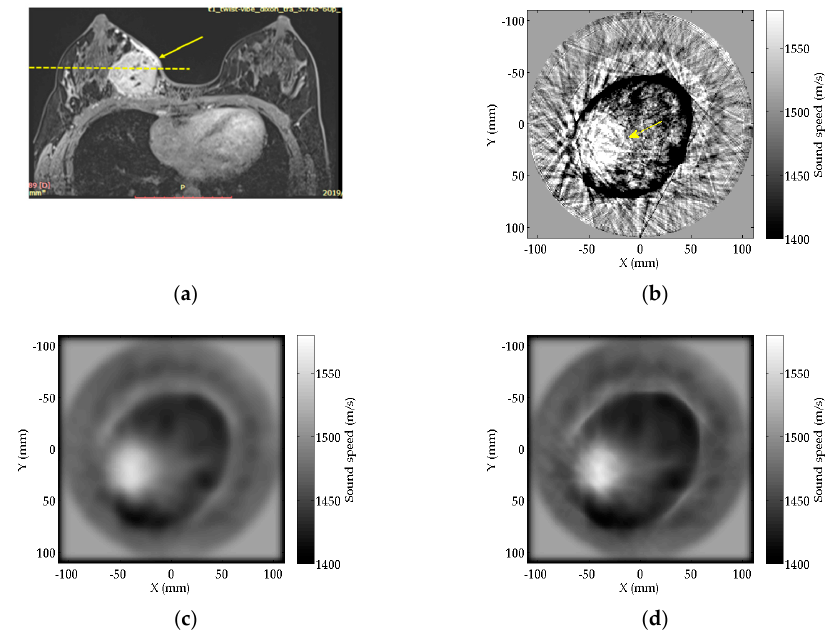
Figure 8. ( a ) MRI result of the patient’s breast; ( b ) reconstructed SS images of the patient’s breast by RTT; ( c ) reconstructed SS images of the patient’s breast by FZTT; ( d ) reconstructed SS images of the patient’s breast by ZSFZTT.